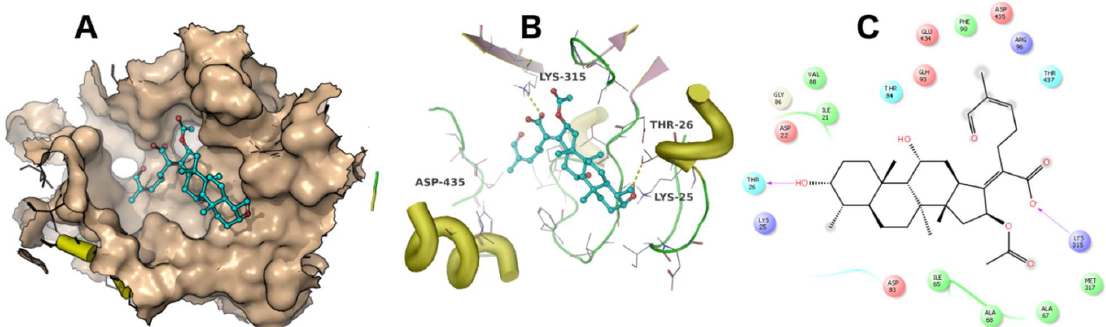
Figure 6. The binding mode of 4. The ligand binding pocket is shown as surface ( A ). The amino acid residues involved in ligand interaction are shown as lines ( B ). A 2D ligand interaction profile is demonstrated in ( C ).